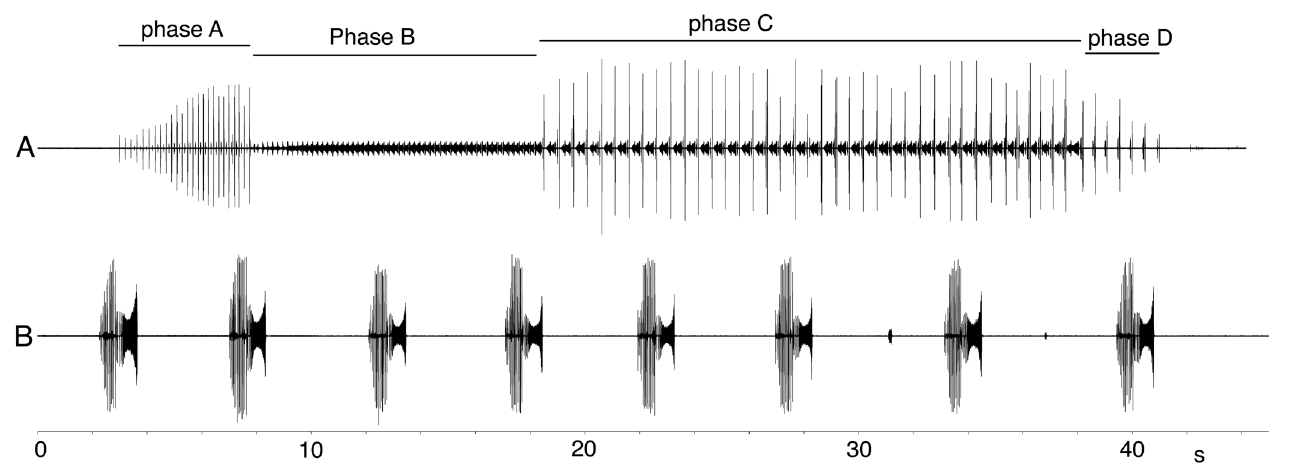
Figure 10. Oscillograms of male calling songs, comparative overview. A. E diuturna sp. n., B. E fulva , In A, the different phases of one song unit are indicated.